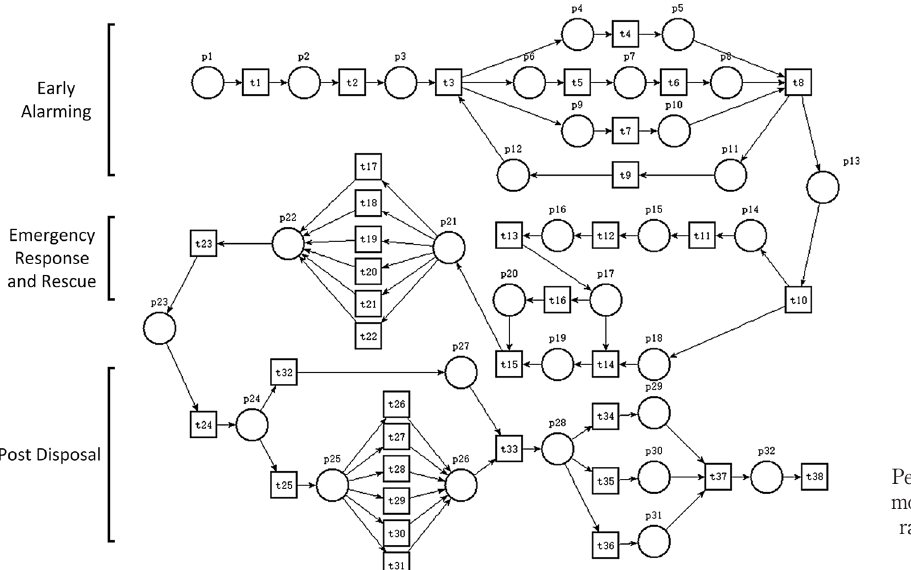
Figure 4. Petri net